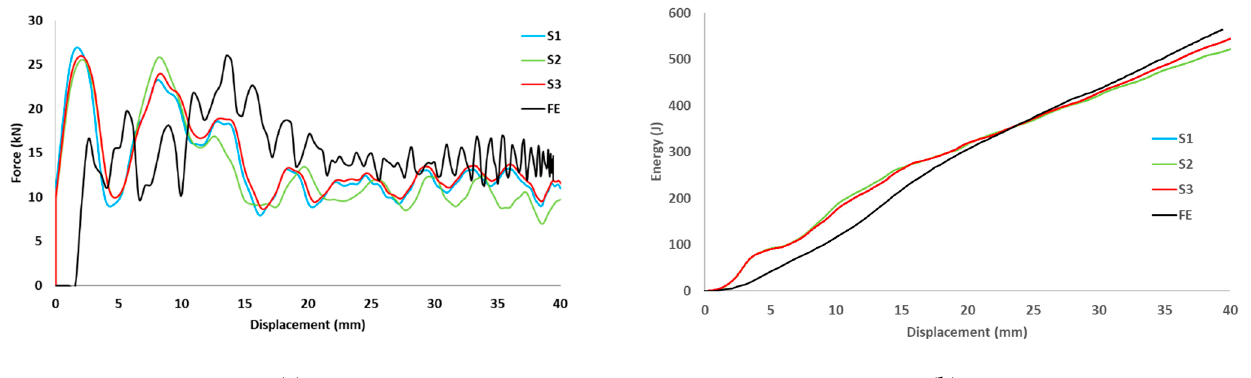
Figure 10. ( a ) Experimental and predicted load vs. displacement curves, ( b ) Energy vs. displacement for hat-shaped crush at crush speed of 3 m/s.